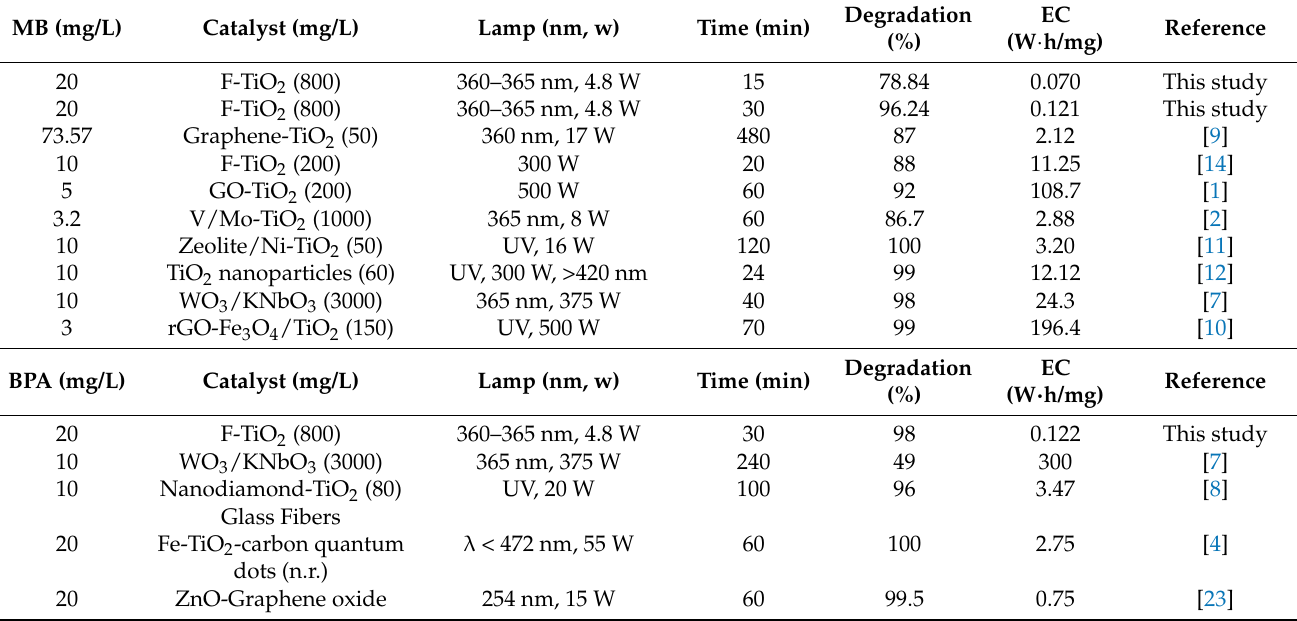
Table 1. Last reported data on MB and BPA UV-photocatalysis degradation.